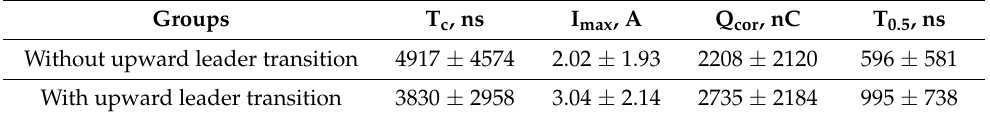
Table 1. Characteristics of the first pulsed streamer corona flash for experiments with elements simulating the tops of rod objects of a different equivalent radius.